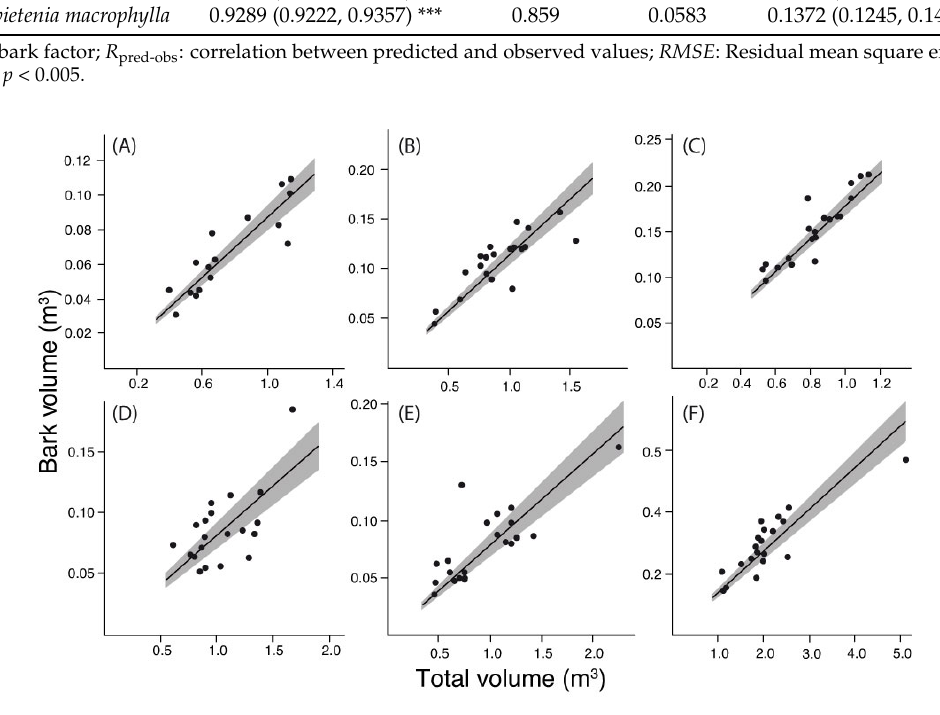
Figure 4. Change in bark volume with total volume of the log. Bark factor ( F ) was calculated from these fits. ( A ) Cordia dodecandra ; ( B ) Lysiloma latisiliquum ; ( C ) Manilkara zapota ; ( D ) Metopium brownei ; ( E ) Swartzia cubensis ; and ( F ) Swietenia macrophylla . In gray, 95% confidence bands for fits.